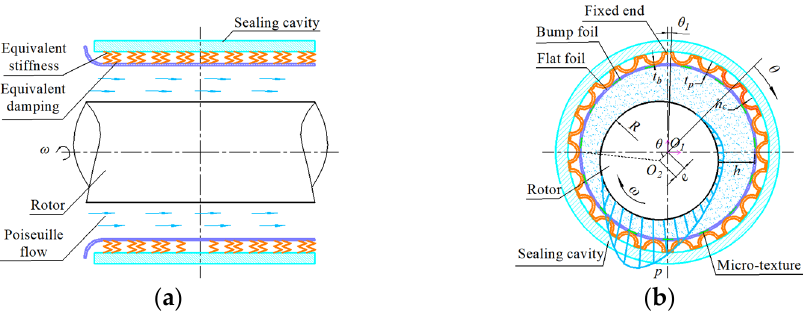
Figure 1. ( a ) Schematic of the compliant foil gas seal. ( b ) Mechanisms for the lubricating gas film